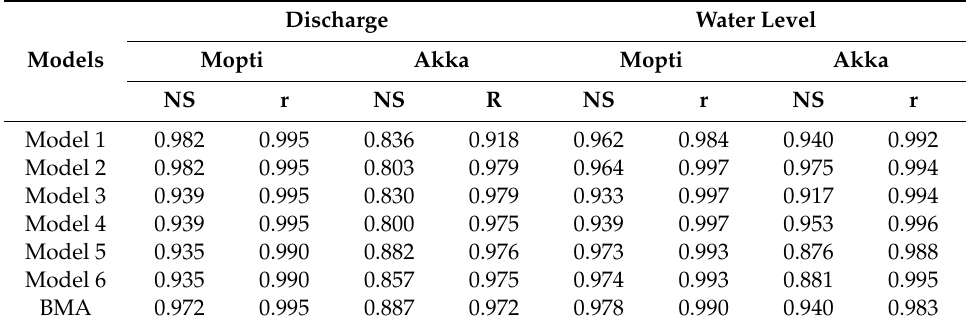
Table 10. Correlation (r) and NS coe ffi cients for simulated discharge and water level in the validation period.